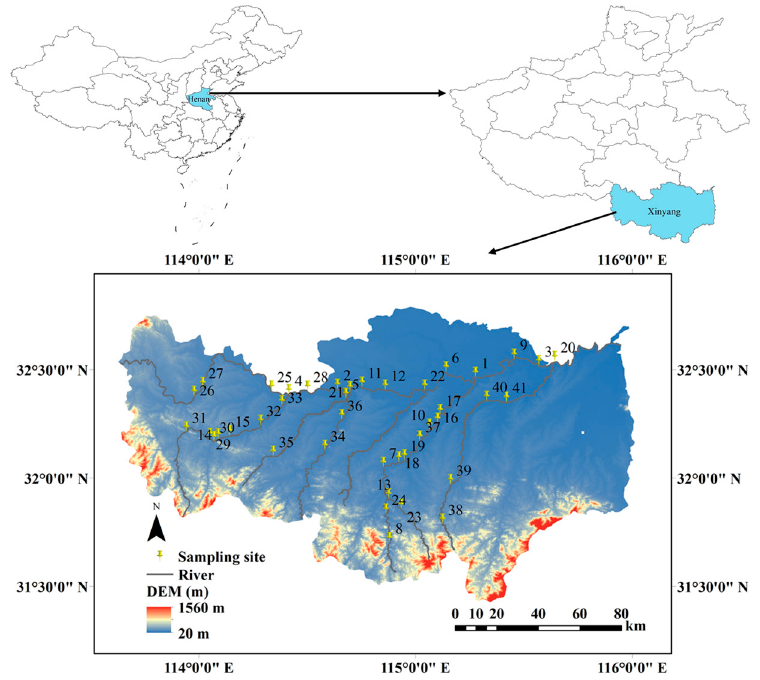
Figure 3. The study area.